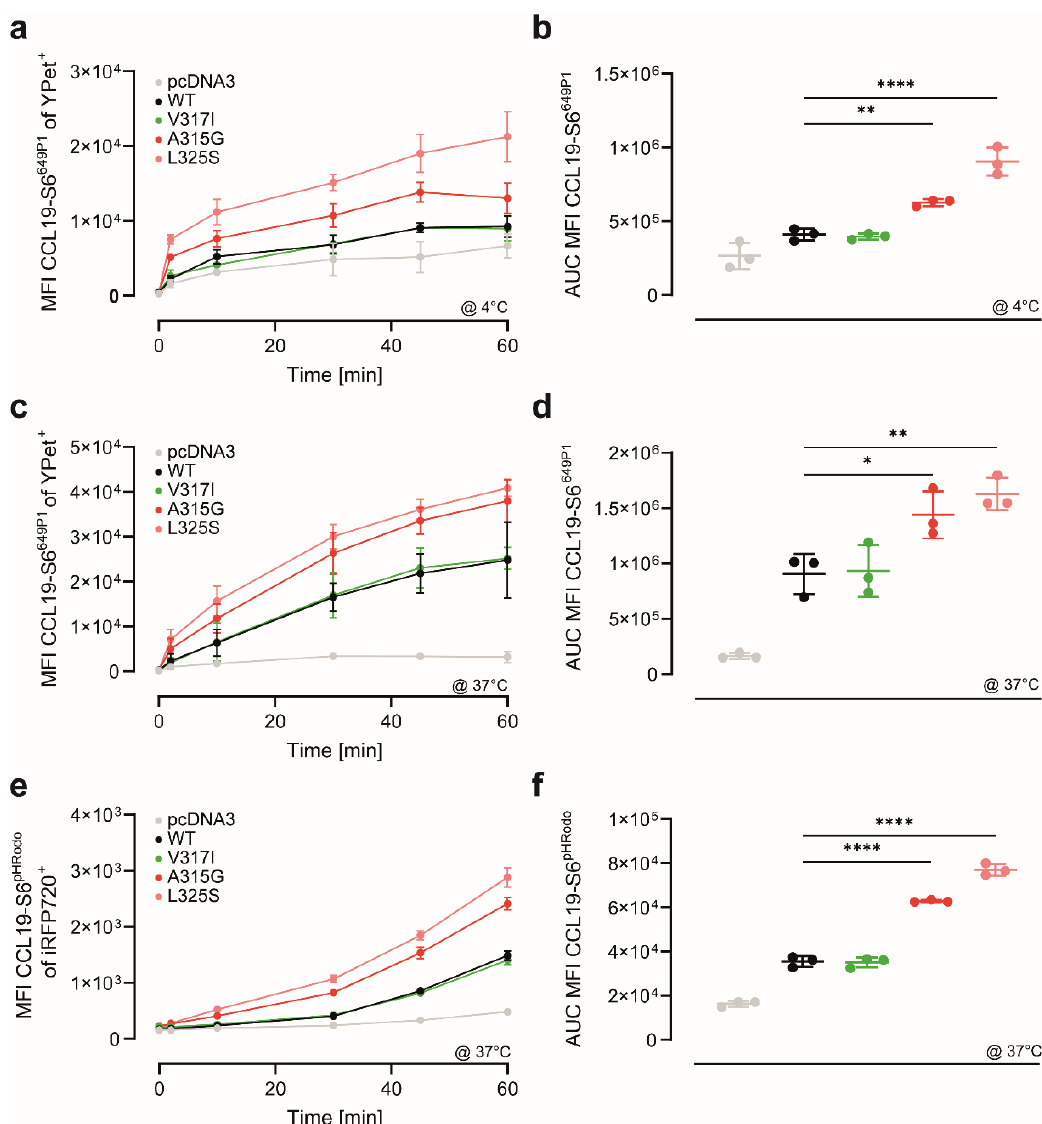
Figure 3. Dimerisation-defective CCR7 mutants own higher CCL19 binding and uptake capacities: ( a ) dimerisation-defective CCR7 mutants are superior in CCL19 binding. HeLa cells were transiently transfected with YPet-tagged CCR7 variants and incubated at 4 ◦ C for indicated time periods with 25 nM of fluorescently labelled CCL19-S6 649P1 . Cells were extensively washed, and mean fluorescence intensities (MFIs) of CCL19-S6 649P1 bound to CCR7 variants were measured by flow cytometry; ( b ) quantification of CCL19-S6 649P1 binding to CCR7 variants. Area under the curve (AUC) of the MFI values over the entire period of measurement; ( c,d ) enhanced CCL19 binding and uptake by dimerisation-defective CCR7 mutants. HeLa cells were transiently transfected with YPet-tagged CCR7 variants and incubated at 37 ◦ C for indicated time periods with 25 nM of fluorescently labelled CCL19-S6 649P1 and assessed by flow cytometry as in ( a , b ); ( e,f ) enhanced CCL19 internalisation by dimerisation-defective CCR7 mutants. HeLa cells were transiently transfected with YPet-tagged CCR7 variants and incubated at 37 ◦ C for indicated time periods with 25 nM of CCL19-S6 pHRodo and assessed by flow cytometry as in ( a , b ); ( a – f ) n = 3, mean ± SD, statistical analysis: one-way ANOVA. * p < 0.05; ** p < 0.01; **** p <